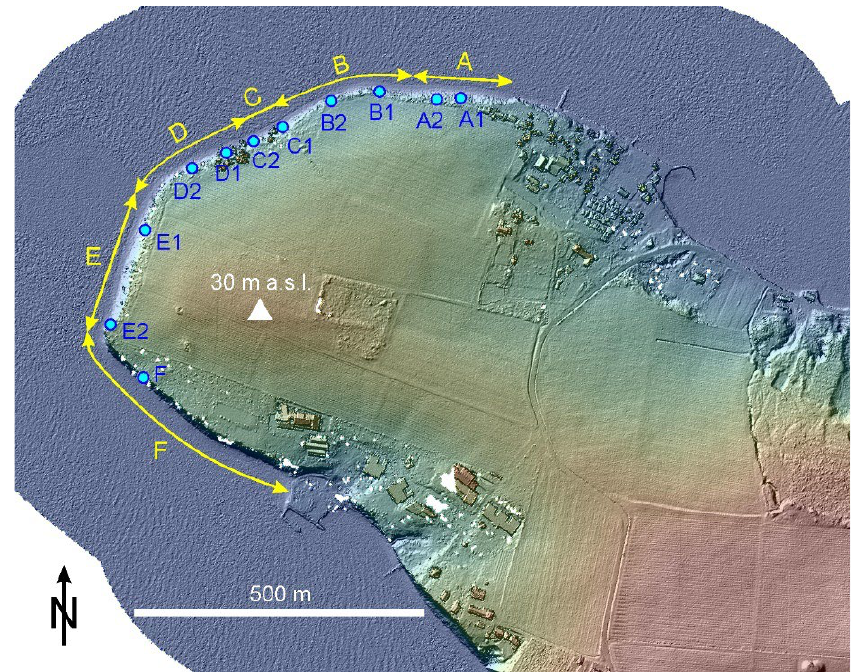
Figure 2. Elevation map of Debeli Rti č obtained from the digital terrain model of the study area (data density: 25 points per m 2 ). The map also identifies the different sectors forming the sea cliff (yellow stretches A ‒ F) and the location of selected outcrops that are therein included (A1, A2, B1, B2, C1, C2, D1, D2, E1, E2, and F).